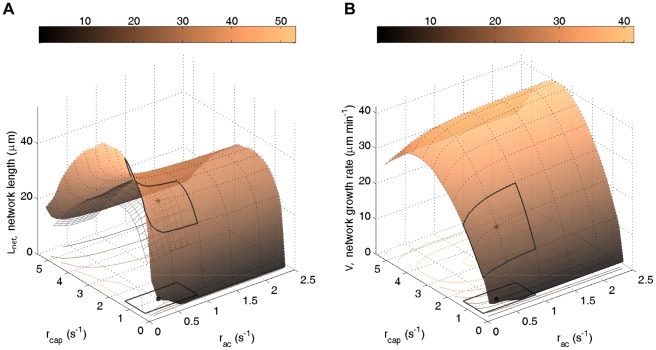
Network length and network growth rate of a rearwards unconfined network.Network length Lnet (A) and network growth rate V (B) are plotted against plus-end capping rate rcap and ADF/cofilin binding rate rac in the absence of tropomyosin (rtm = 0 s−1). Parameters plausibly applying to living cells (0.03 s−1<rac<1 s−1, 0.5 s−1<rcap<1.5 s−1) are encircled with black rectangles. The mesh plot in (A) represents the case of neglected ADF/cofilin deactivation (rac
− = 0 s−1), while rac
− = 0.2 s−1 otherwise. 15×13 data points were calculated and spline-interpolated for each plot.